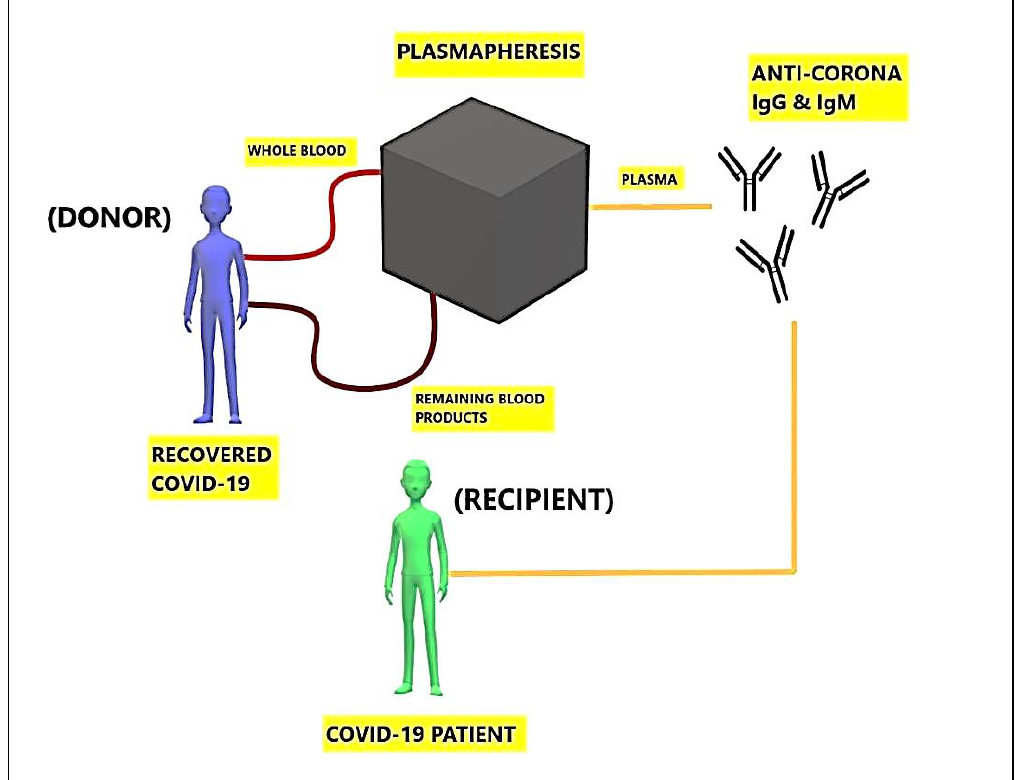
Figure 1. Fundamentals of convalescent plasma